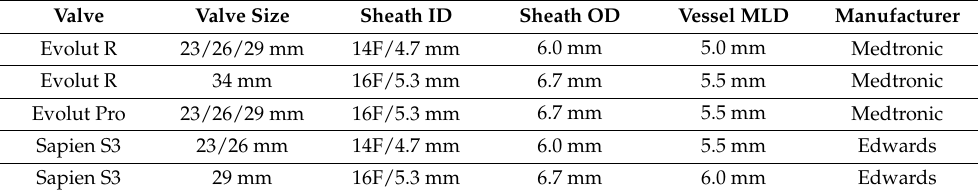
Table 1. Minimal vessel diameters required for valve